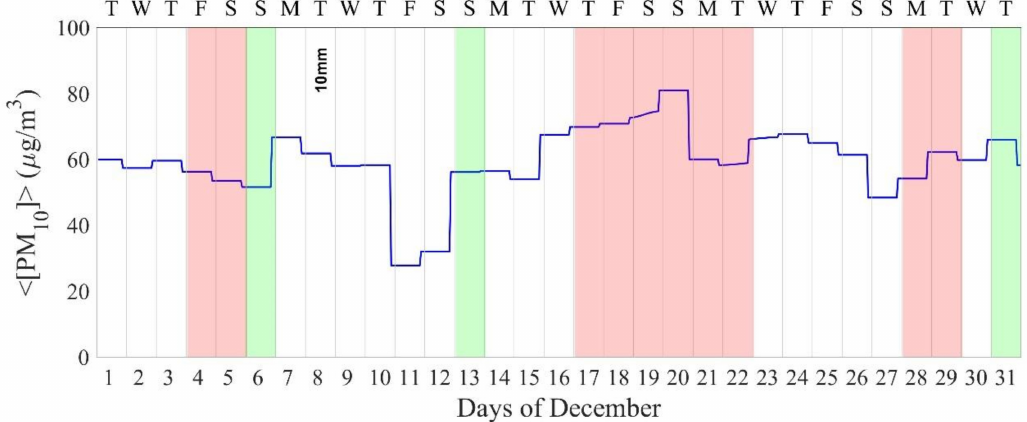
Figure 14. Particulate matter PM 10 concentration variation related to the total block of urban traffic (green band) and alternated plates (red band) of December 2015. The blue line is the hourly pollutant concentration. Data of daily precipitation are indicated in mm.